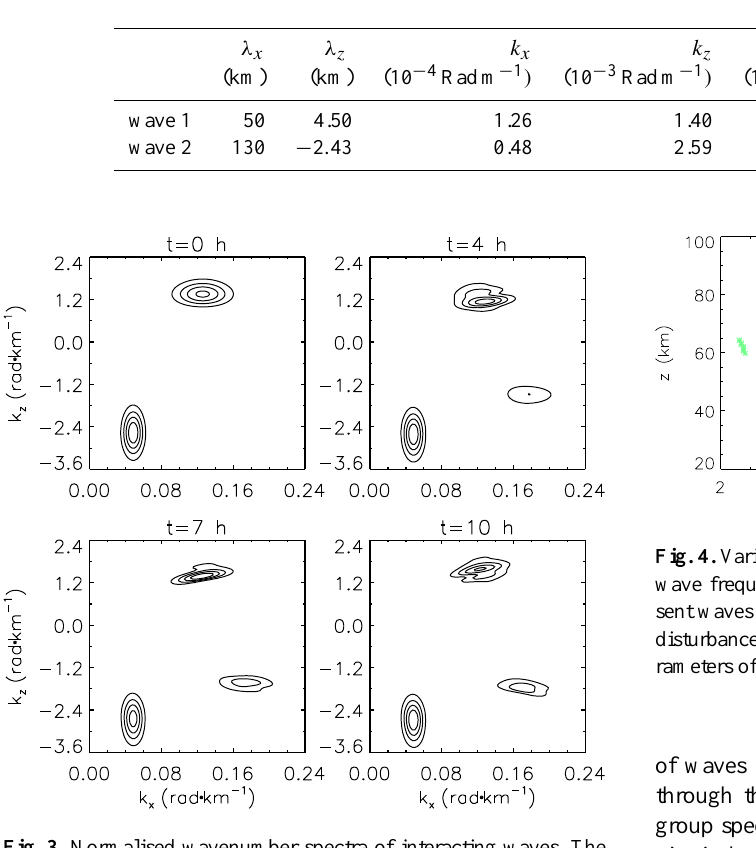
Fig. 3. Normalised wavenumber spectra of interacting waves. The values of contours are 0.2, 0.4, 0.6 and 0.8.